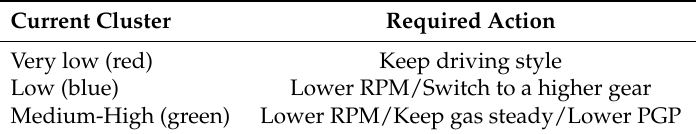
Table 5. Actions that are associated to the three-cluster classification.